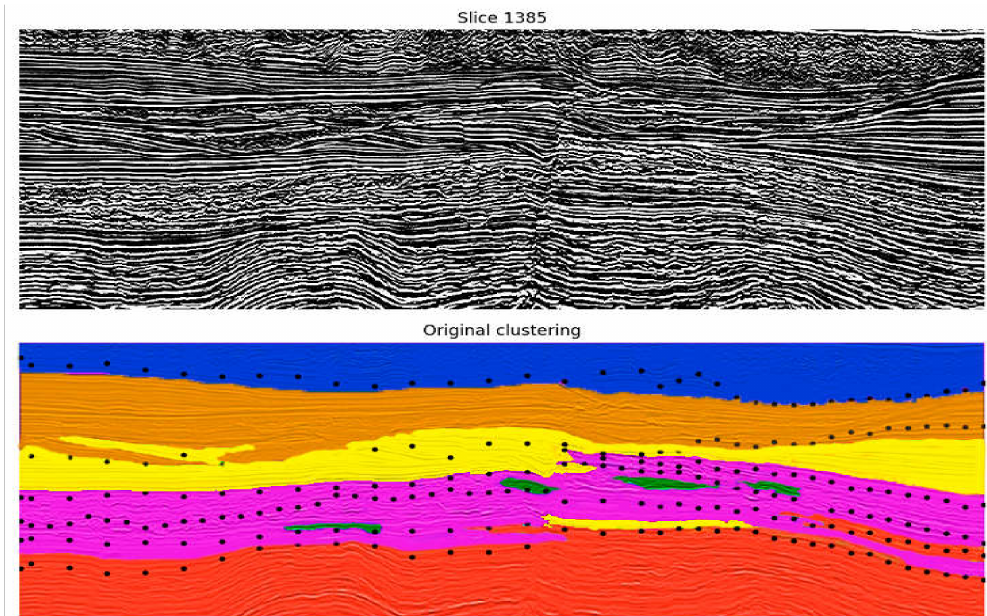
Figure 13. Results from the clustering of Watershed segments using k-Means (6 groups) and an image composed of Texture Dissimilarity, Amplitude, Similarity Cross Average. The top image shows the original vertical seismic slice; the bottom one shows the Watershed results. Black dots in the lower figure indicate main geological boundaries according to geophysicist’s interpretation of the top figure (conventional seismic data). One can conclude that a good fit occurs between clustering results and geophysicist’s preliminary interpretation.